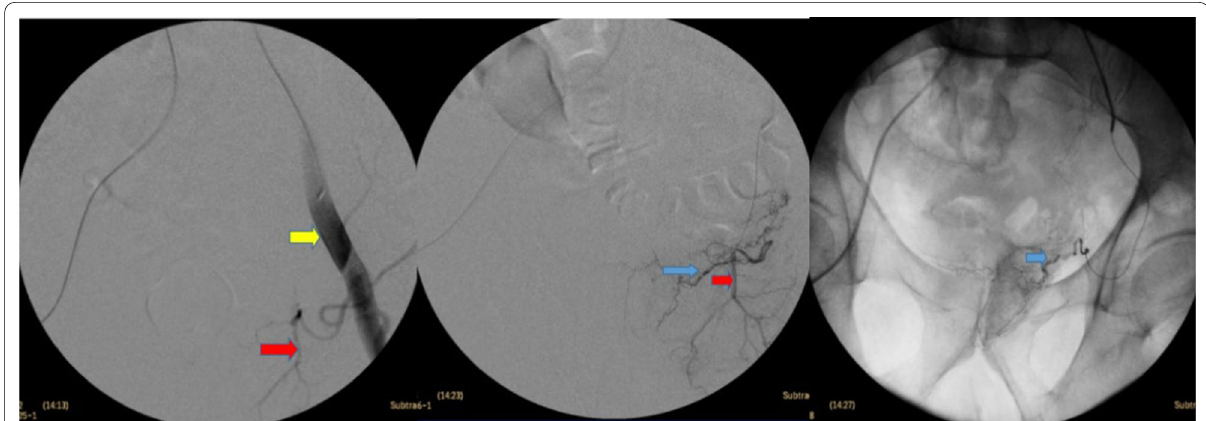
Fig. 9 Angiography images showing the origin of left prostatic artery (blue arrow) from obturator artery (red arrow), from EIA (yellow arrow)